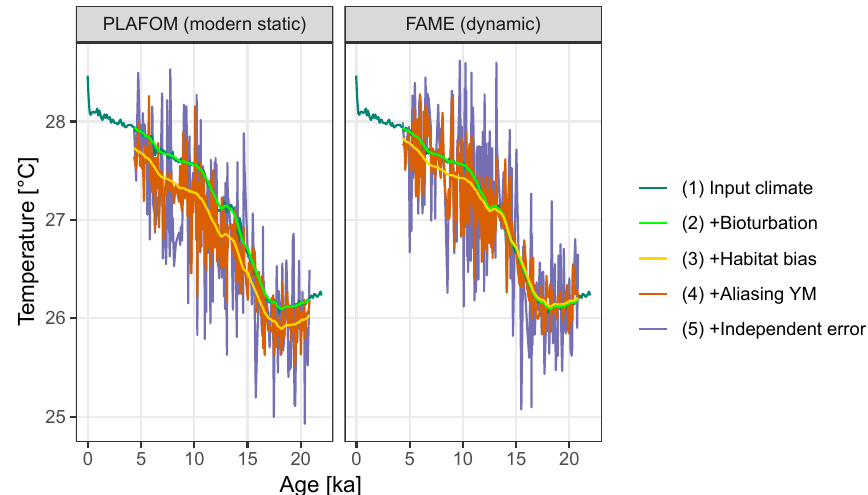
Figure 5. A comparison of forward modelled Mg / Ca-based pseudo-proxies using static and dynamic seasonal weighting.